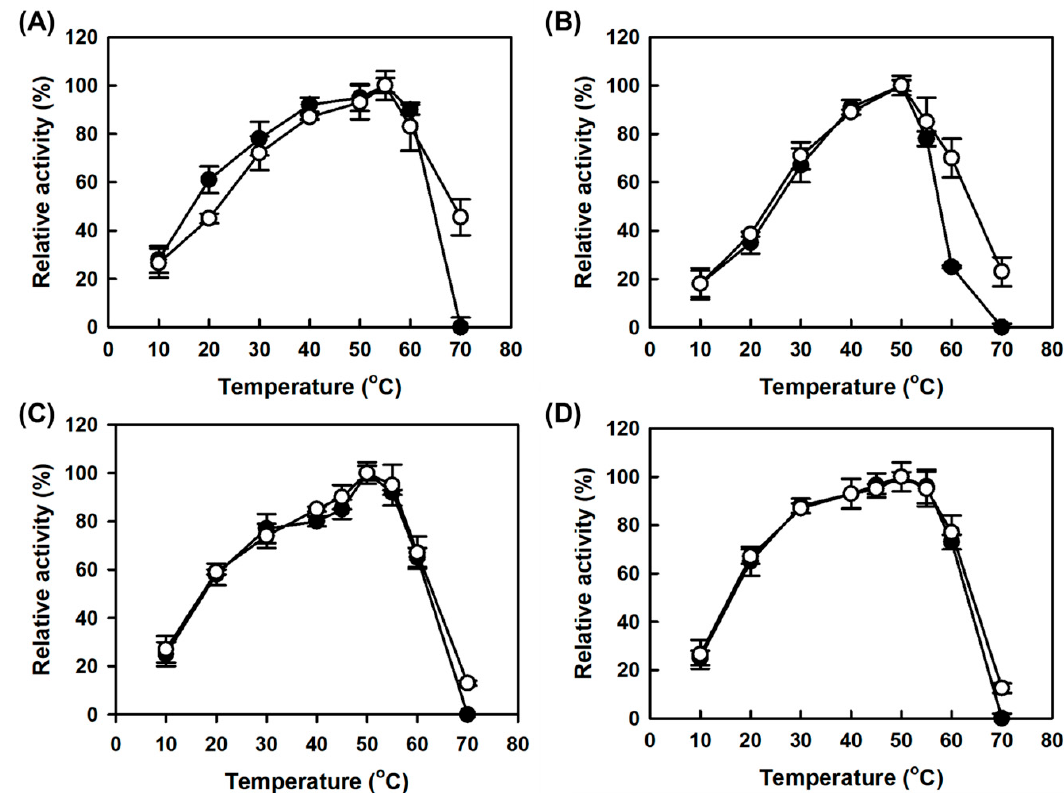
Figure 4. Effect of temperature on activity of free and CLEAs enzymes. ( A ) Monoamine oxidase activity for AMAO2 ( ● ) and combi-CLEAs ( ○ ) using tyramine as the substrate, ( B ) monoamine oxidase activity for MAPO ( ● ) and CLEAs-MAPO ( ○ ) using tyramine as the substrate, ( C ) putrescine oxidase activity for APUO ( ● ) and combi-CLEAs ( ○ ) using putrescine as the substrate, ( D ) putrescine oxidase activity for MAPO ( ● ) and CLEAs-MAPO ( ○ ) using putrescine as the substrate. The activities of amine oxidases were measured according to the peroxidase-coupled assay [16]. Upon determining optimal temperatures of the enzymes, the reactions were carried out at the optimum pH of each enzyme and a temperature ranging from 10 to 70 ° C.